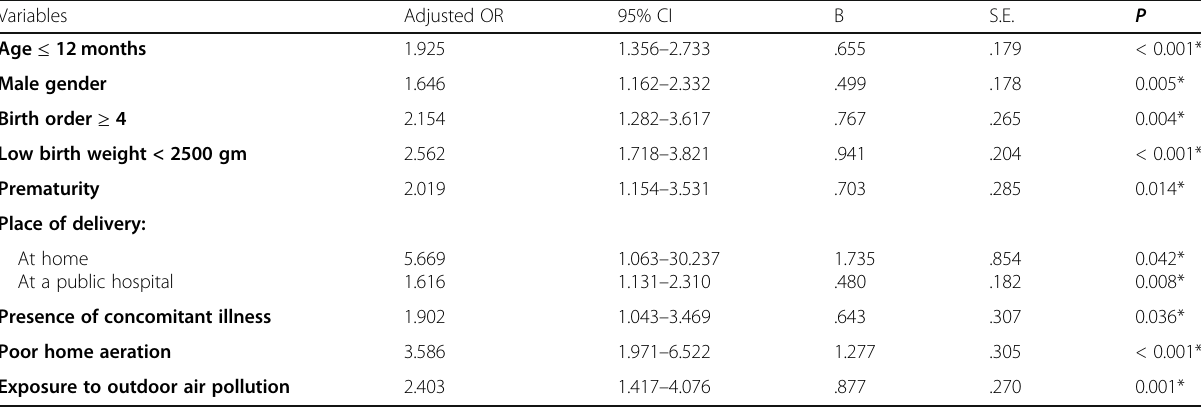
Table 3 Risk factors independently associated with pneumonia among under-five children (Results of logistic regression) Variables